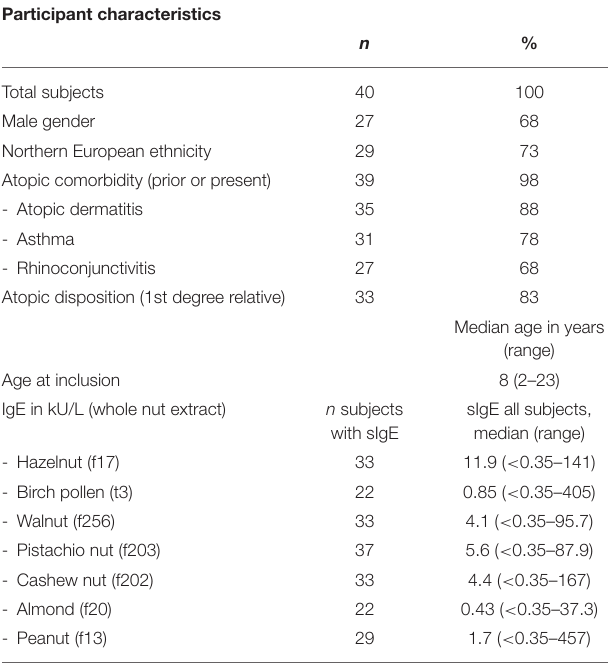
TABLE 2 | Participant’s demographics, morbidity, and sensitization